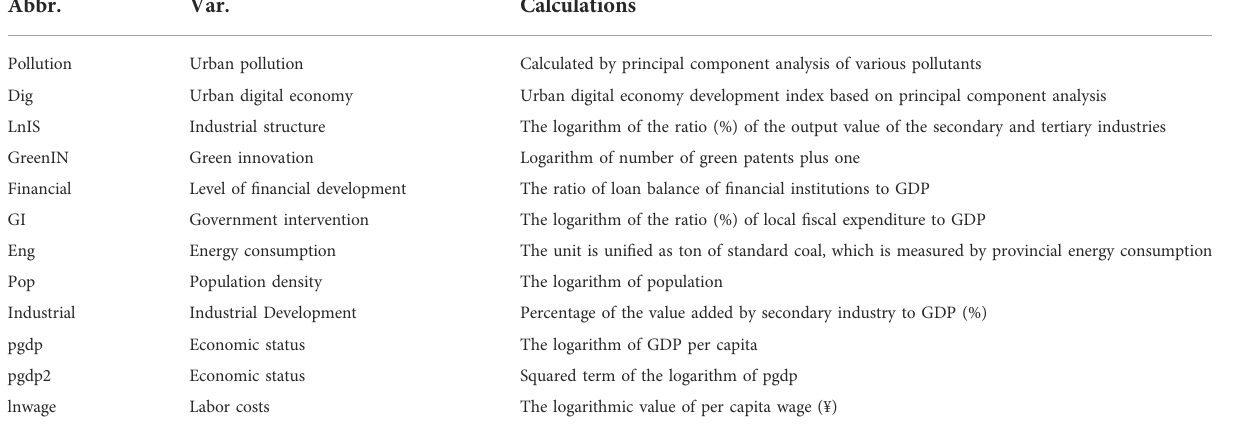
TABLE 2 Variables with their calculations.